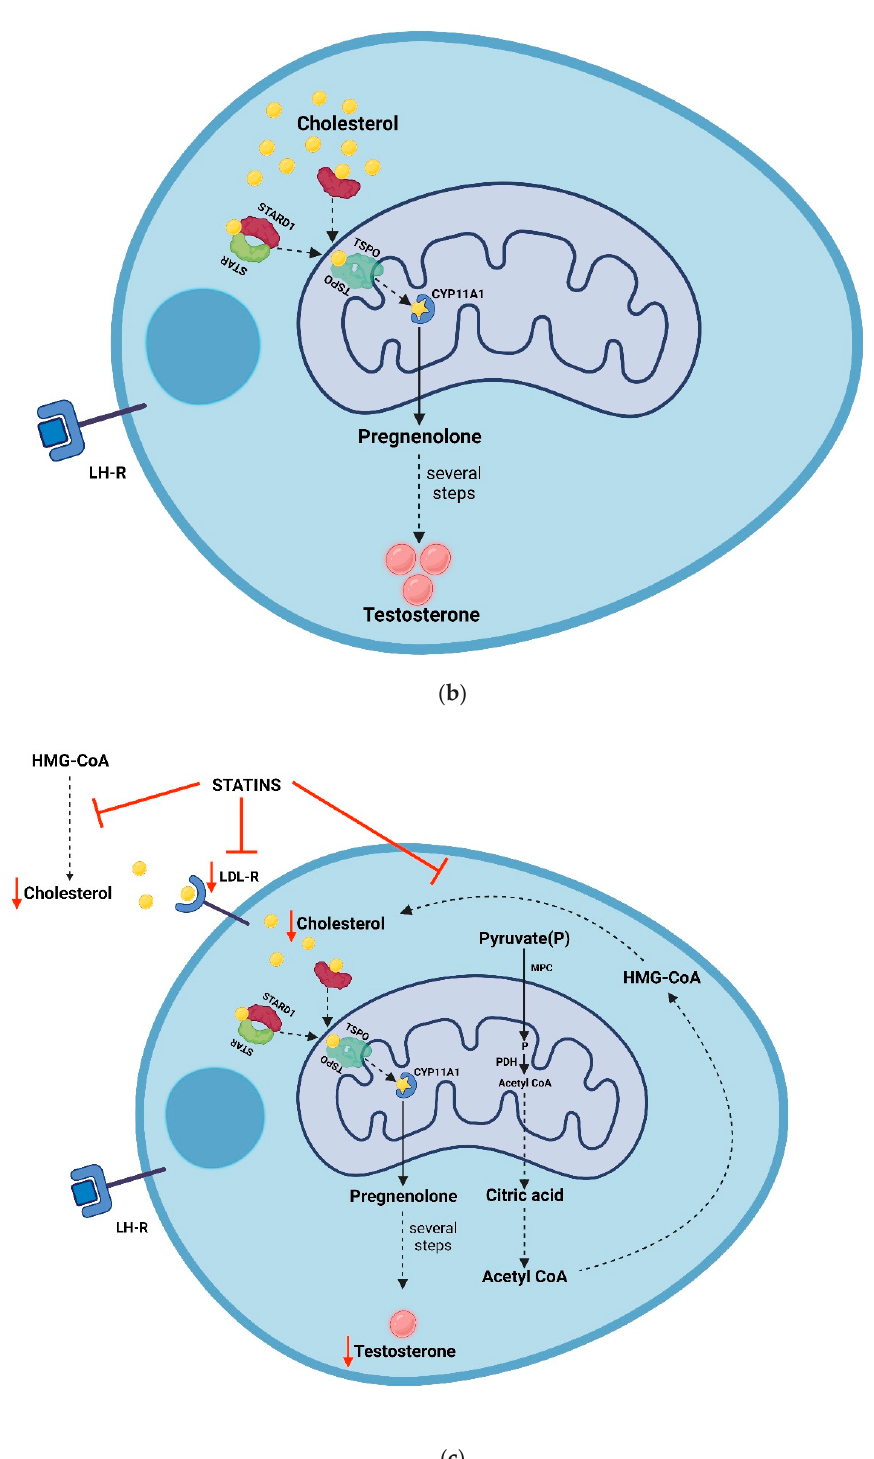
Figure 3. The mechanisms through which statin may impact male fertility. ( a ). Cholesterol bioavail- ability in a Leydig cell; ( b ). Testosterone synthesis in a Leydig cell; ( c ) Routes through which statins affect male reproduction. The Leydig cell can absorb cholesterol from the blood via low density lipoprotein- receptors (LDL-R) and are also capable of de novo cholesterol synthesis. The de novo synthesis of cholesterol starts with pyruvate being generated from diverse cytosolic sources. Entry of pyruvate into the mitochondrial matrix is mediated by the mitochondrial pyruvate carrier (MPC). In the matrix, pyruvate is converted into acetyl CoA or oxaloacetate by pyruvate dehydrogenase